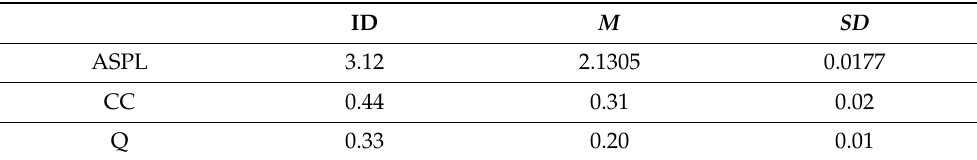
Table A8. Random Network comparison for the network of the adolescents with ID (dataset 7), p < 0.001 for all comparisons.